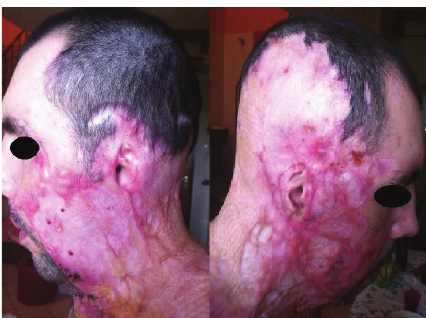
Figure 1: The photography of the subject before surgery. There are evidences of extensive scarring, asymmetry and deformity of face, neck, and truncus. The auricular pinnas are mutilated; the external auditory canals are